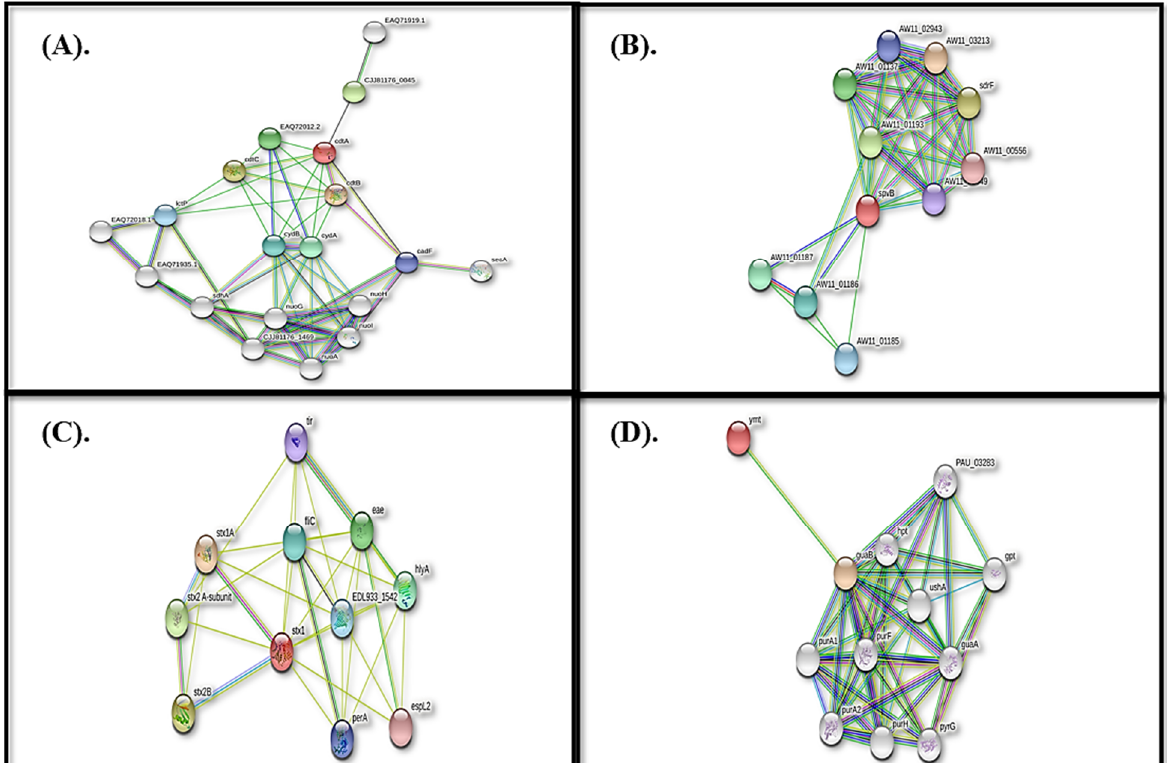
Figure 11. Interactome prediction through STRING. ( A ) ctd ( B ) spvB ( C ) stxB and ( D )